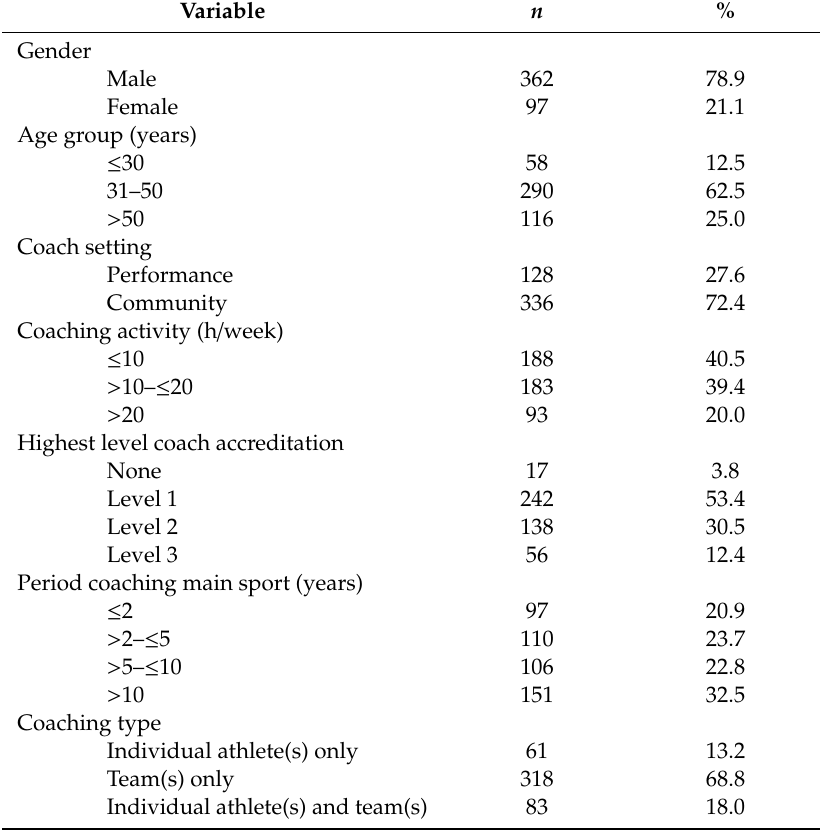
Table 1. Demographic characteristics of